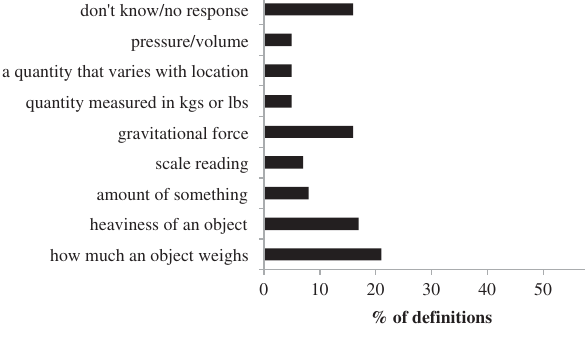
FIG. 2. Definitions of weight, pretest.